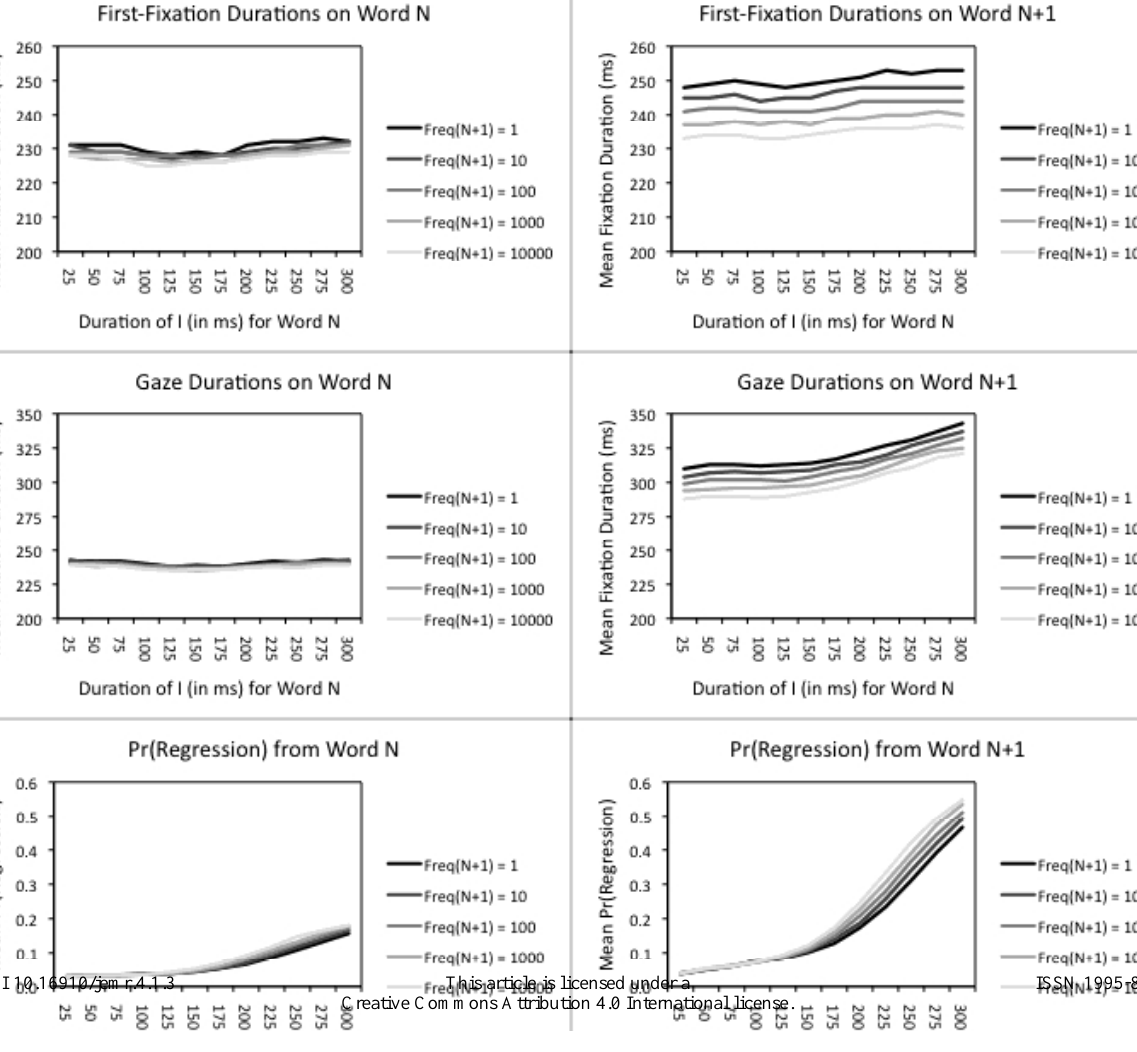
Results of E-Z Reader simulations varying the duration of post-lexical processing, t(I), on word N and the frequency of word N+1.